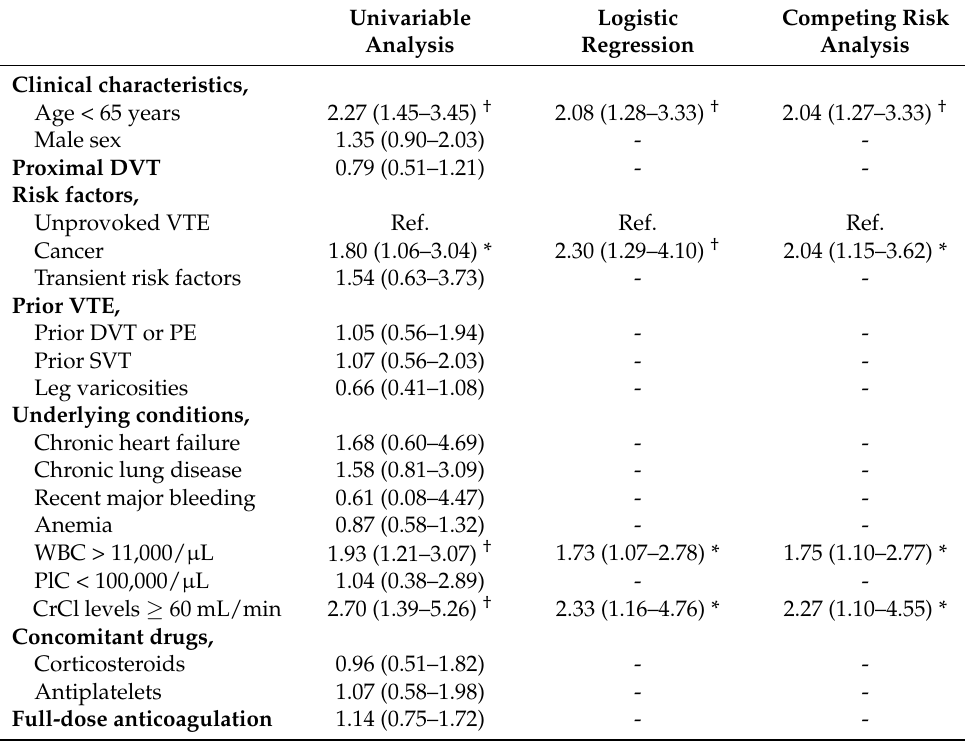
Table 5. Uni- and multivariable analysis for VTE